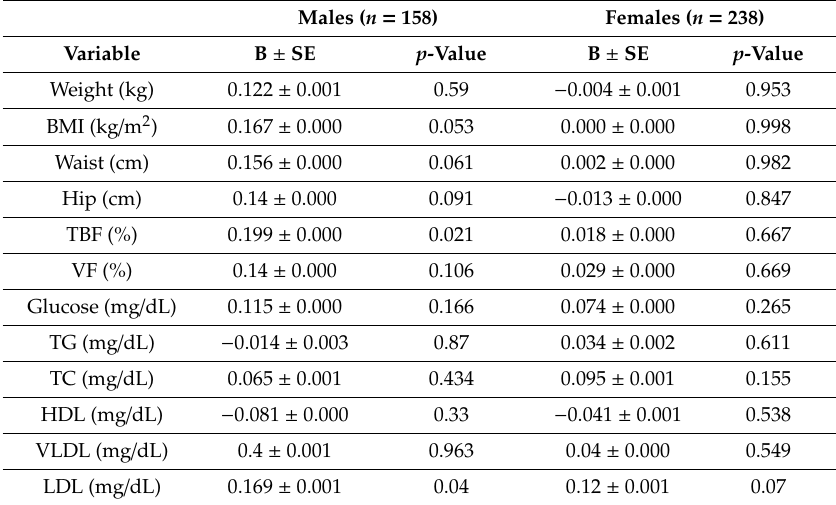
Table 4. Predictive models of caloric soft drink intake on the anthropometric and metabolic variables of metabolic risk in males and females, using bivariate regression analysis. Males ( n =